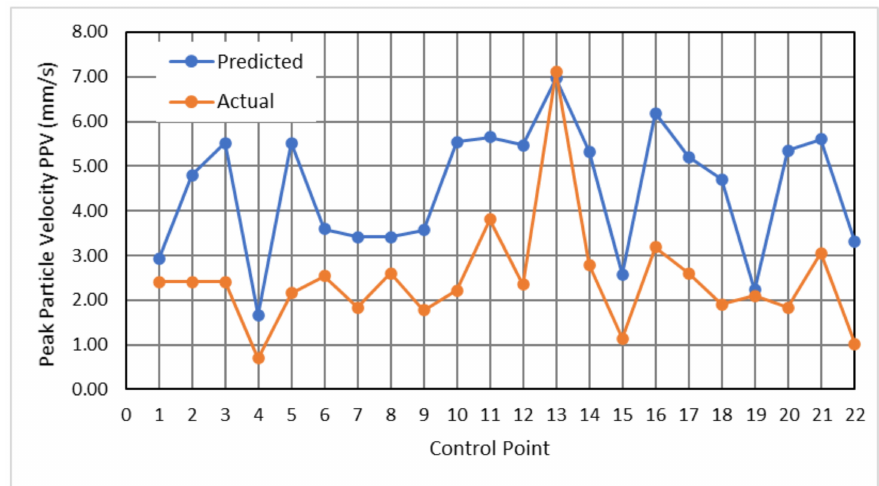
Figure 11. Comparison of the PPV (mm/s) predicted and recorded.